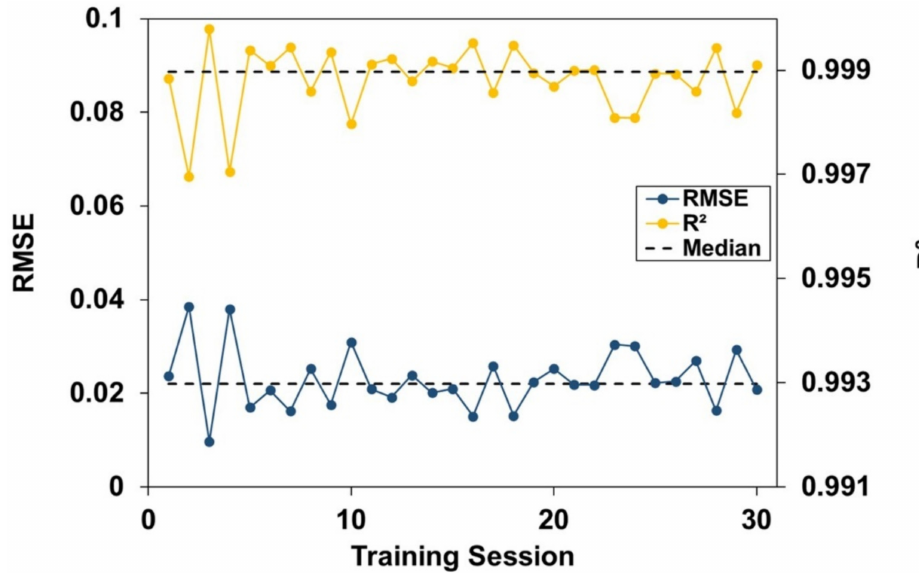
Figure 9. Performance metrics of the BR-trained FFNN1 consisting of 50 hidden neurons.